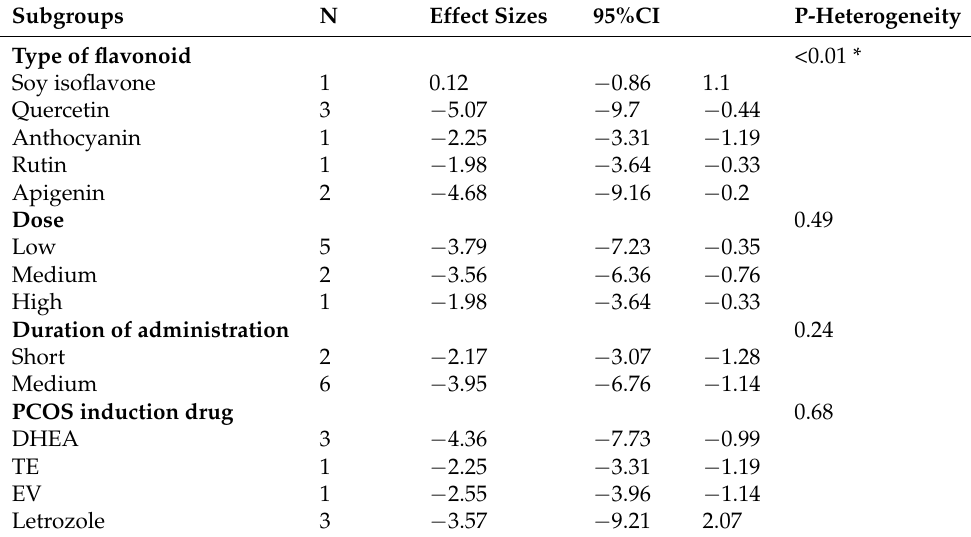
Table 2. Subgroup analysis of flavonoids effect on count of cystic